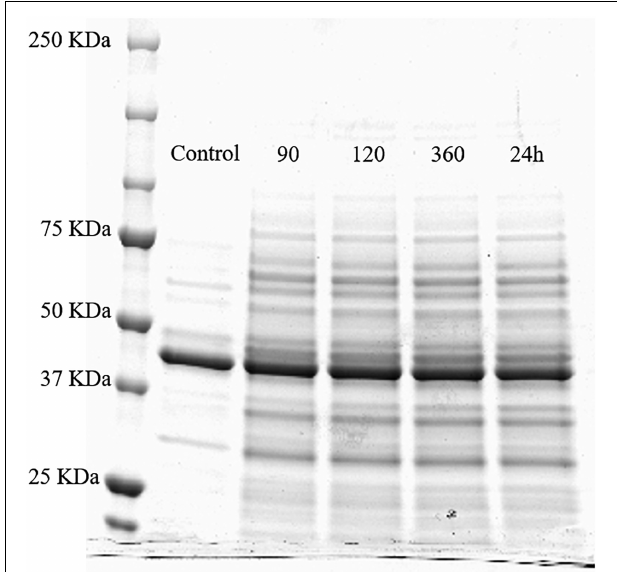
FIGURE 6 | SDS-PAGE profile of whole cell proteins (500 µ L OD 600 nm = 10) of the untreated Lactobacillus acidophilus 08 (control) and HPH treated cells after 90, 120, and 360 min, and 24 h upon the